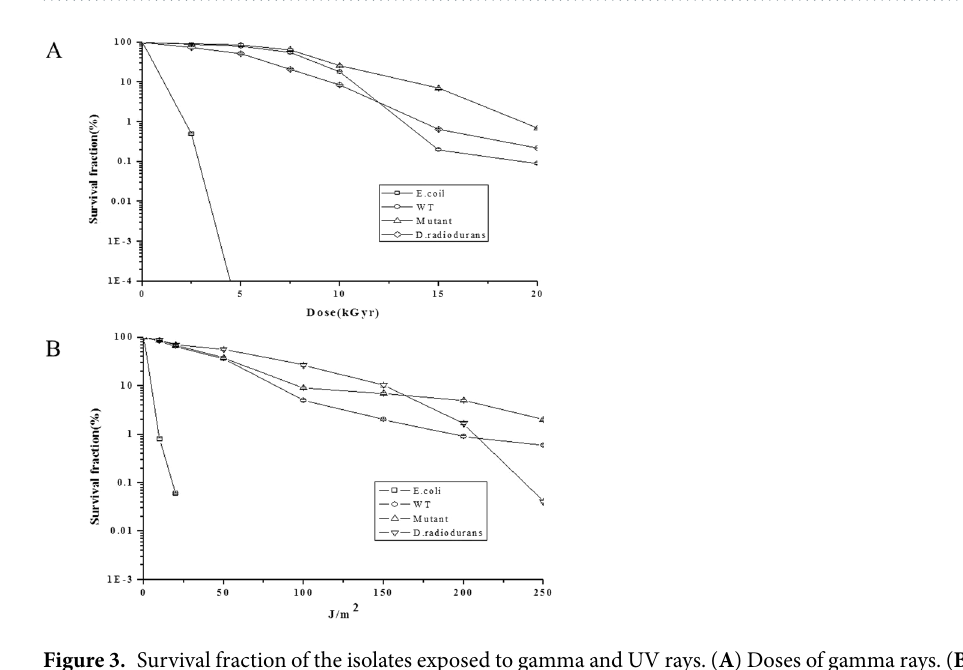
Figure 3. Survival fraction of the isolates exposed to gamma and UV rays. ( A ) Doses of gamma rays. ( B ) Doses of UV rays. The isolates of Aureobasidium strain wild-type AP and modified mutant strain AP T ∆ A were test with E. coli as a negative contrast and D. radiodurans as a positive contrast. Each error bar indicates the average value obtained in the three